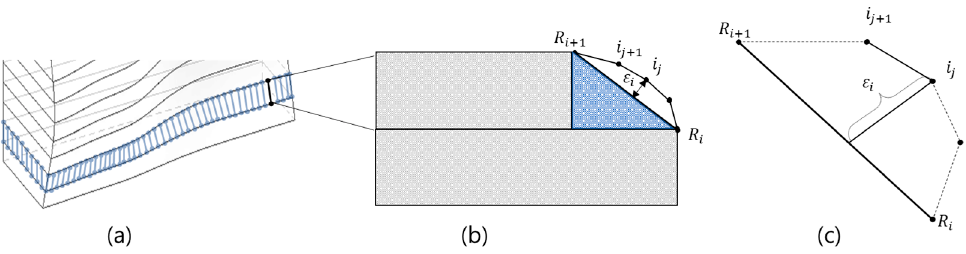
Figure 2. Schematic of the slicing; ( a ) generator curves and ruled surface; ( b ) cross-section with respect to a ruling line; ( c ) ruling line and surface errors.